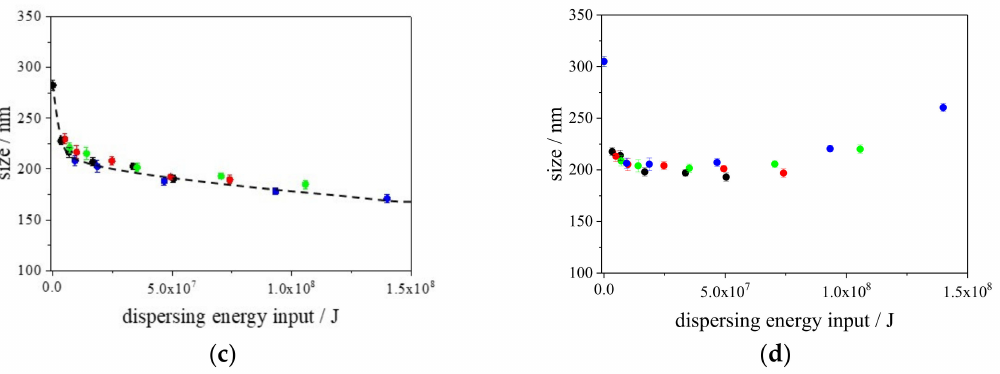
Figure 2. Plots of the mean sizes of CaCO 3 particles in various aqueous media as functions of the dispersing energy input, as determined by DLS. ( a ) Triton X-100, ( b ) SDS, ( c ) Softanol-70, and ( d ) CTAB were used as surfactants. The plots are for different pressures in the narrow channel (80 MPa: black, 120 MPa: red, 180 MPa: green, and 240 MPa: blue). The uncertainties were calculated from the repeatability of the measured sizes, which were obtained from three separate measurements. The dotted curves were calculated using Equations (4)–(6), respectively.